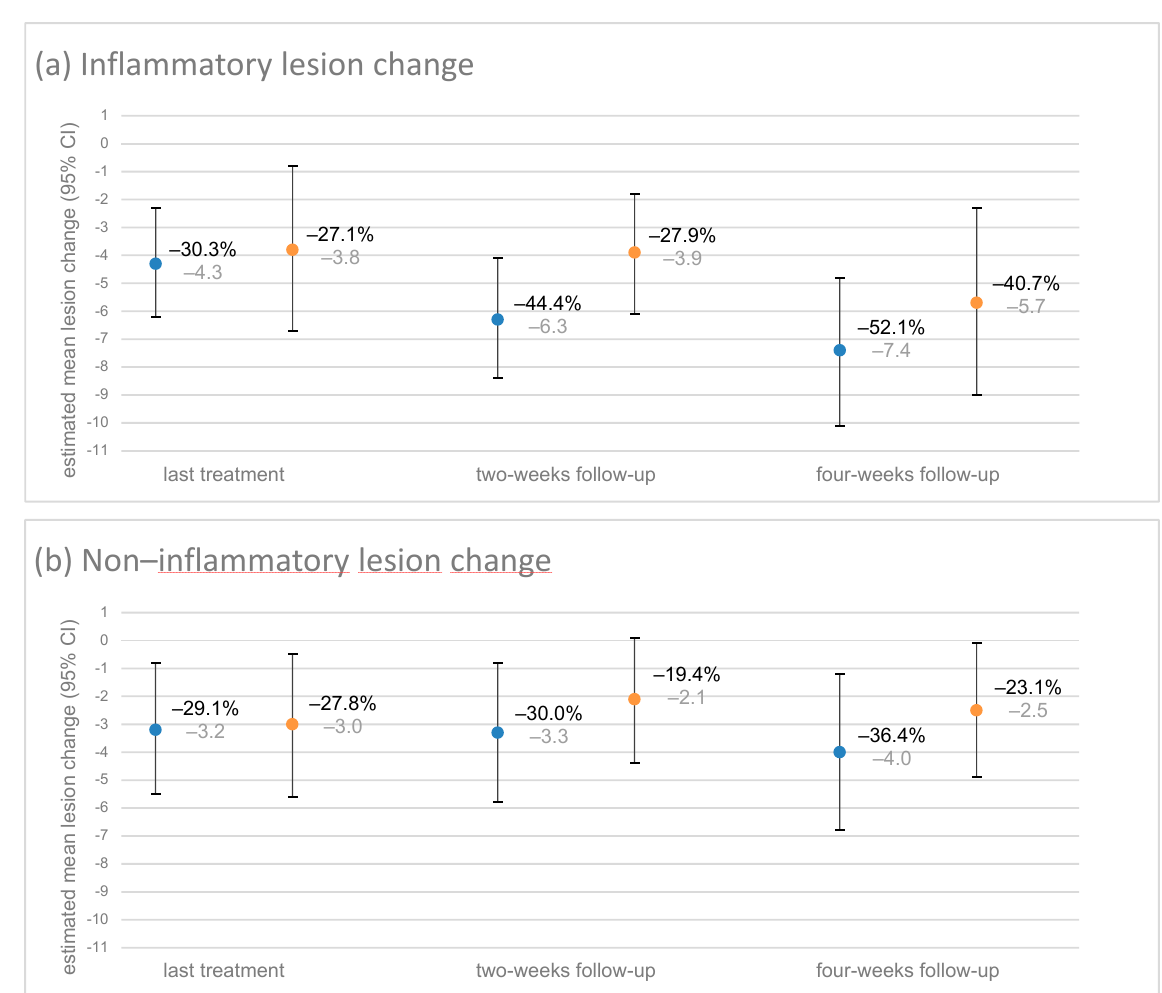
Figure 4. Primary and secondary efficacy endpoints: change in inflammatory lesions ( a ) and non-inflammatory lesions ( b ). Blue = treated side; orange = non-treated side. Mixed linear models (MLMs) were used to compare the change in the number of inflammatory and non-inflammatory lesions between the treated and the non-treated side. MLMs additionally included the fixed effects of the number of applied plasma treatments, the type of treatment, the interaction of the treatment type with the number of applied plasma treatments and the baseline number of lesions. Presented are the estimated/adjusted means with corresponding 95% confidence interval (CI) out of six separate MLMs (three time points and two types of lesion). The mean change in the number of lesions was additionally presented as mean change in percentage. In total, 29 patients had a valid lesion count; 25 patients had 10 plasma treatments, and 4 patients 8 treatments. Mean reduction in the number of lesions did not significantly differ between the treated side and the untreated side.